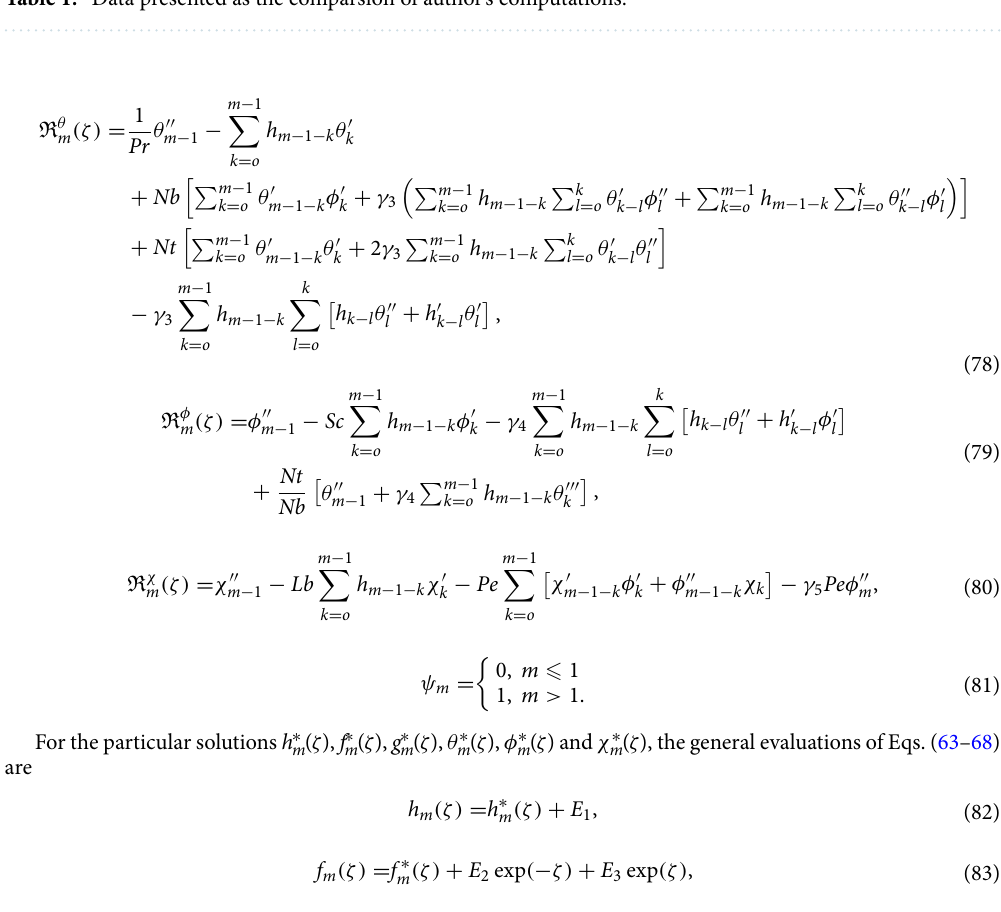
Table 1. Data presented as the comparsion of author’s